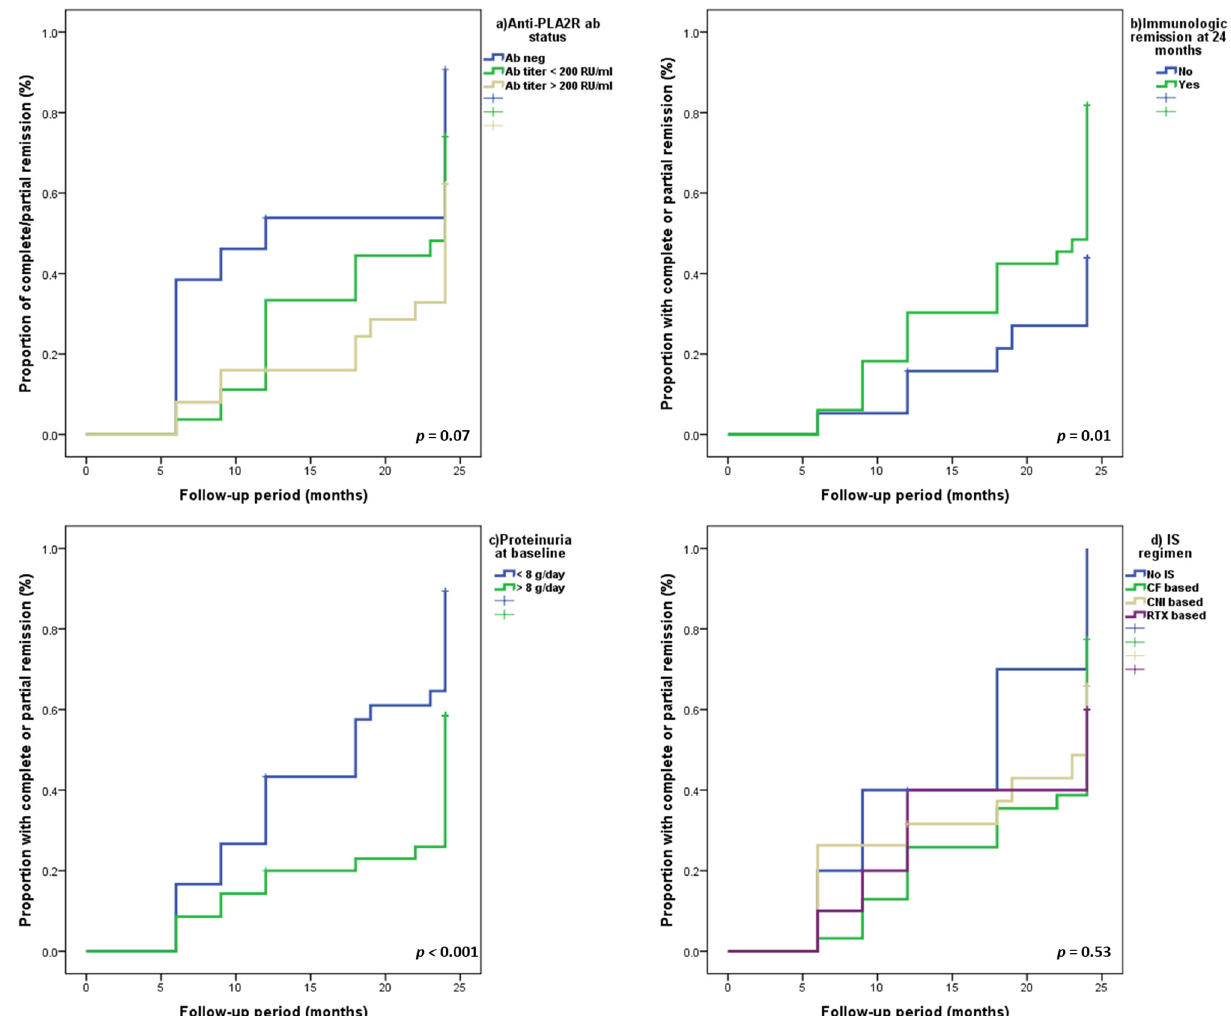
Figure 2. Cumulative proportion of patients with complete or partial remission according to: ( a ) PLA2R status, ( b ) immunological remission at 24 months, ( c ) baseline proteinuria and ( d ) IS regimen.